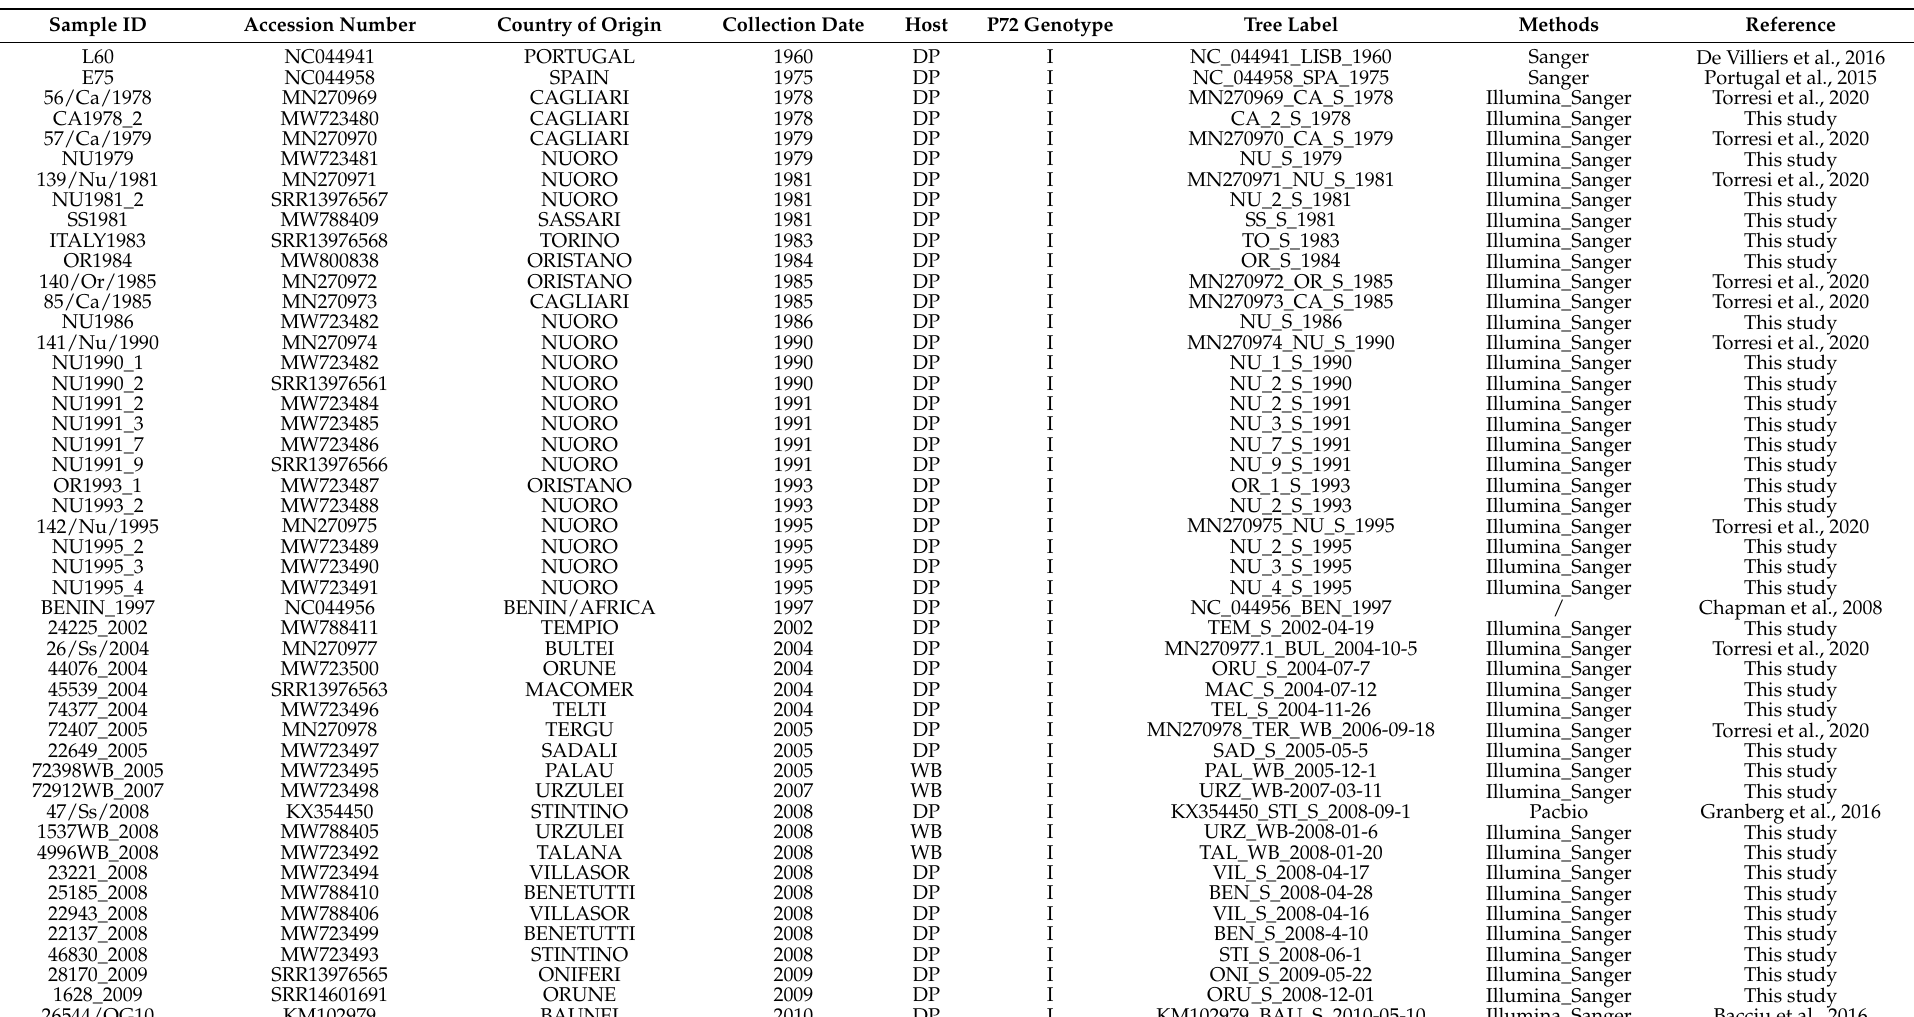
Table 1. Metadata associated with the ASFV whole genomes analyzed in this study. GenBank accession number and tip labels used in the phylogenetic trees are also reported. DP: domestic pig; WB: wild board; FRP: free-ranging